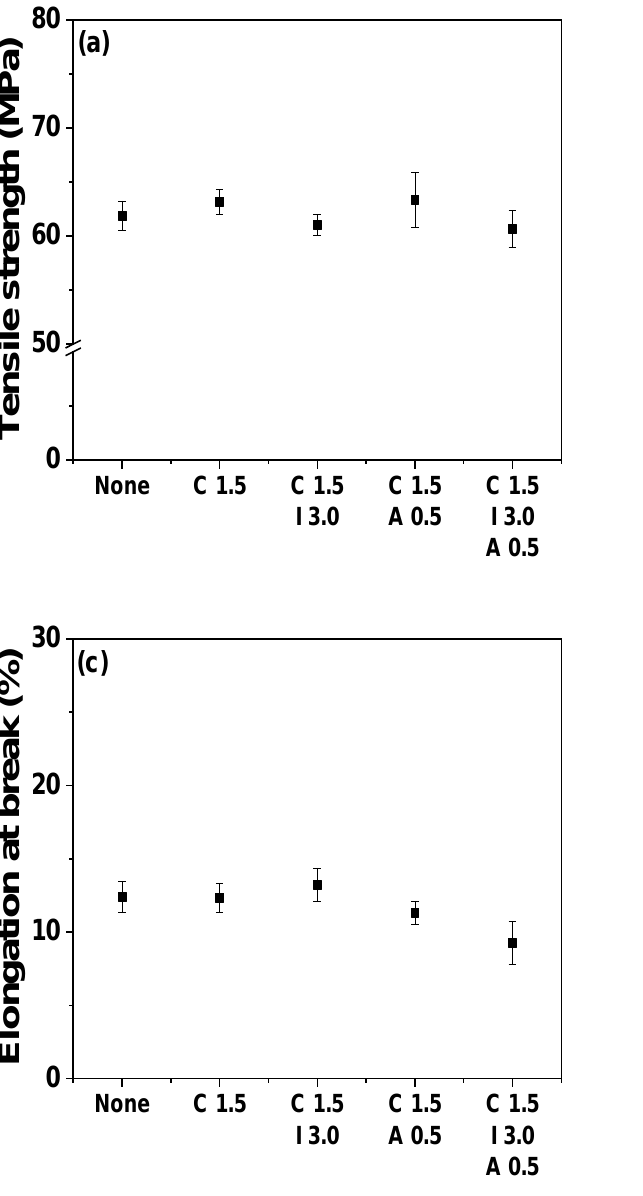
Figure 11. Tensile properties ( a – c ) and Izod impact strength ( d ) of POM/C1.5, POM/C1.5/I, POM/C1.5/A, and POM/C1.5/I3/A0.5 nanocomposites: ( a ) tensile strength; ( b ) tensile modulus; ( c ) elongation at break; ( d ) Izod impact strength.